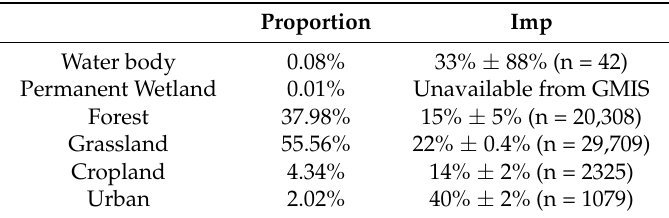
Table 5. Land cover